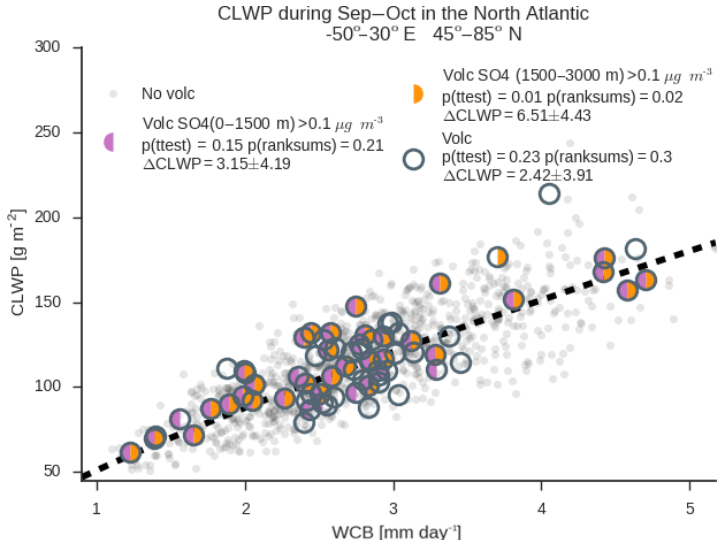
Figure 17. The behavior of cyclones as a function of WCB moisture flux are contrasted for September and October during the eruption of Holuhraun and during all other years. The CLWP in the North Atlantic (50 ◦ W–30 ◦ E, 45–85 ◦ N) in September and October is shown as a function of WCB moisture flux during all years except 2014 (grey dots), during 2014 (grey circles), and for cyclones that the NAME dispersion model predicted to have interacted with the sulfur plume from Holuhraun (purple and orange half-circles). NAME was used to simulate the Holuhraun plume assuming it extended from 0 to 1500m at its source (purple) or from 1500 to 3000m (orange). The mean sulfate mass within the southwest quadrant of each cyclone was calculated. Only cyclones with a sulfate mass of 0.1µgm − 3 were considered to have interacted with the plume. A power law fit of climatological CLWP to WCB moisture flux in the region is shown as a dashed line. This fit was used to calculate anomalies in CLWP for cyclones in September and October except 2014, for September and October of 2014, and for the cyclones that NAME predicted to have interacted with the plume. A t test and a non-parametric rank sum test were used to evaluate the difference in means between the climatological anomalies in CLWP and the anomalies in 2014 and for the cyclones that NAME predicted had interacted with the plume. The p values for these tests are given in the legend. Differences in means and 95% confidence intervals, assuming a normal distribution, are also given. Latitude ranges of 35–90 and 30–90 ◦ N are shown in Figs. S14 and